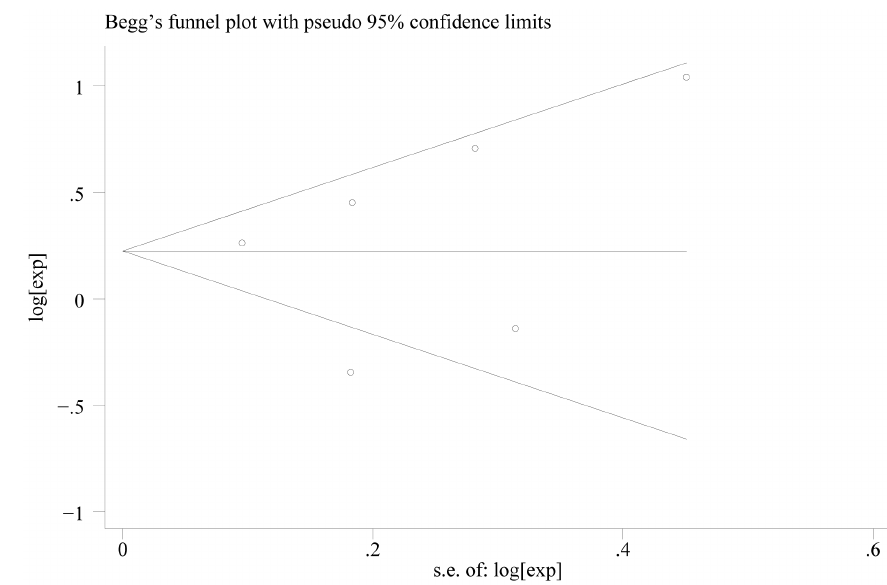
Figure 7. Begg’s test result of OS in non-Asian.